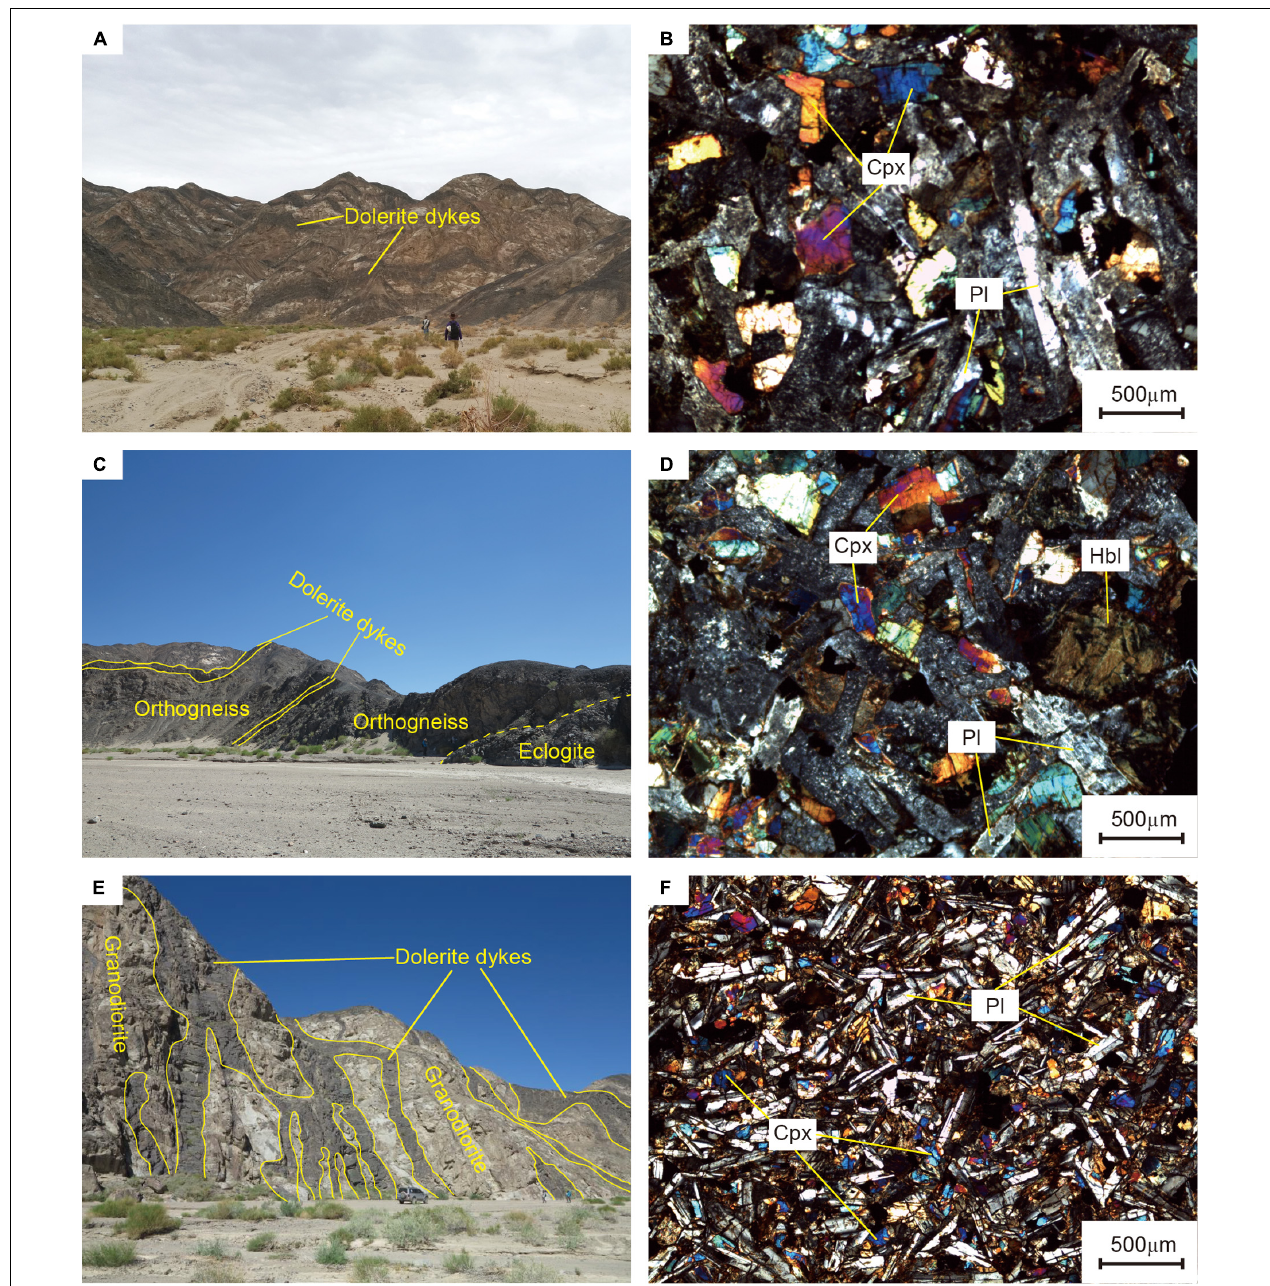
FIGURE 2 | Outcrops of dolerite dykes and photomicrographs of representative dolerite dykes from Gubaoquan. (A) Gubaoquan Dolerite dykes intruded into Precambrian orthogneisses. (C) Gubaoquan dikes between orthogneisses and eclogite. (E) Gubaoquan dikes intruded into Silurian-Devonian granodiorite country rocks. (B,D) Clinopyroxene, plagioclase and hornblende within the Gubaoquan dikes. (F) Showing the ophitic texture. Cpx, clinopyroxene; Pl, plagioclase; and Hbl,